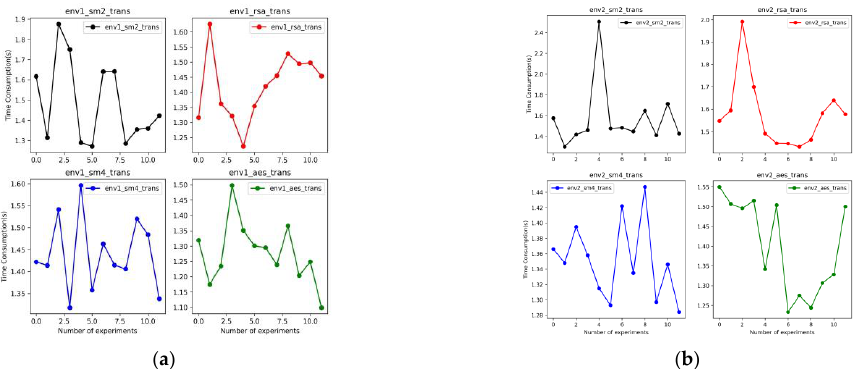
Figure 10. Time consumption for simulating transmission public keys to DRC using SM2, SM4, AES, and RSA in env-1 ( a ) and env-2( b ).